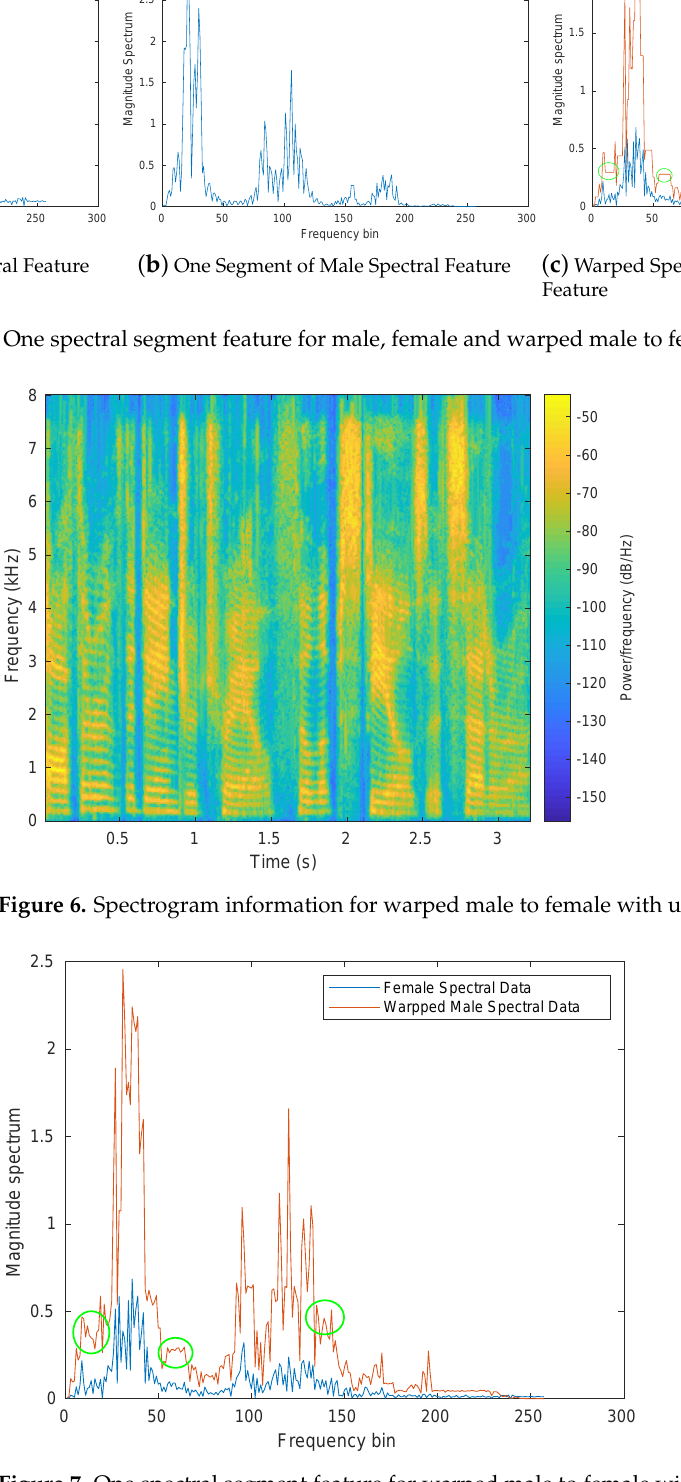
Figure 7. One spectral segment feature for warped male to female with